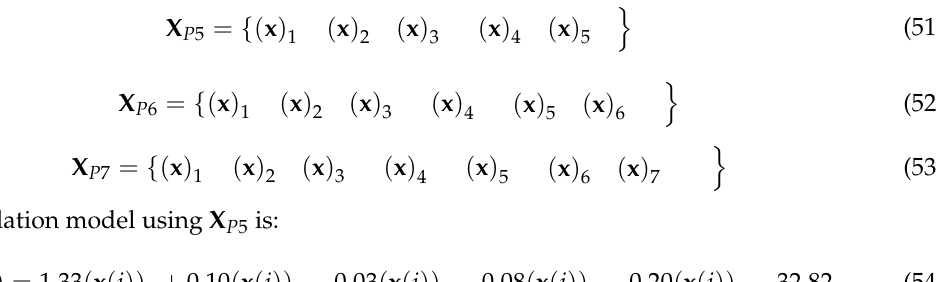
( a ) the curve of the reconstructed value and the actual value; and ( b ) the curve of the reconstruction error.